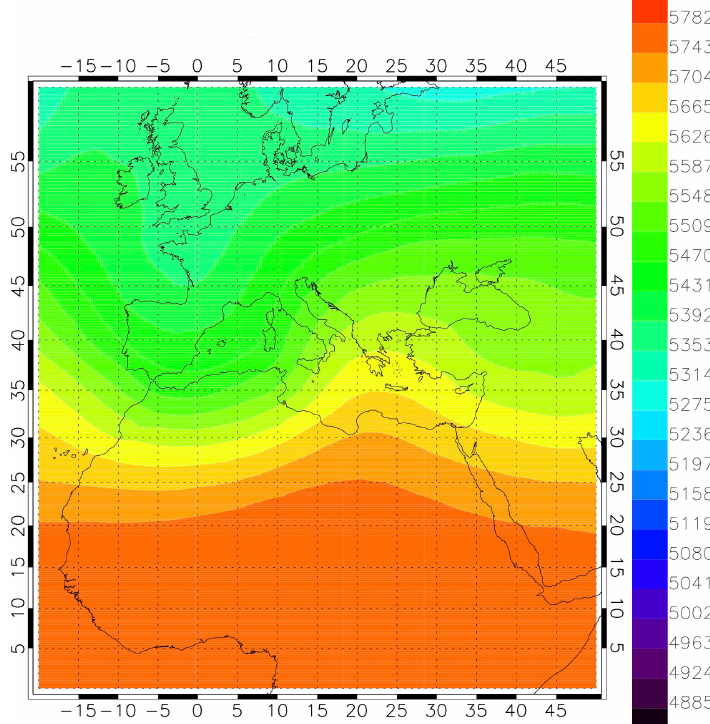
Figure 2. Averaged (at 00 UTC for the selected 15 “dust events”) geopotential height (m) at 500 hPa. The maps are generated using Copernicus Climate-Change Service Information